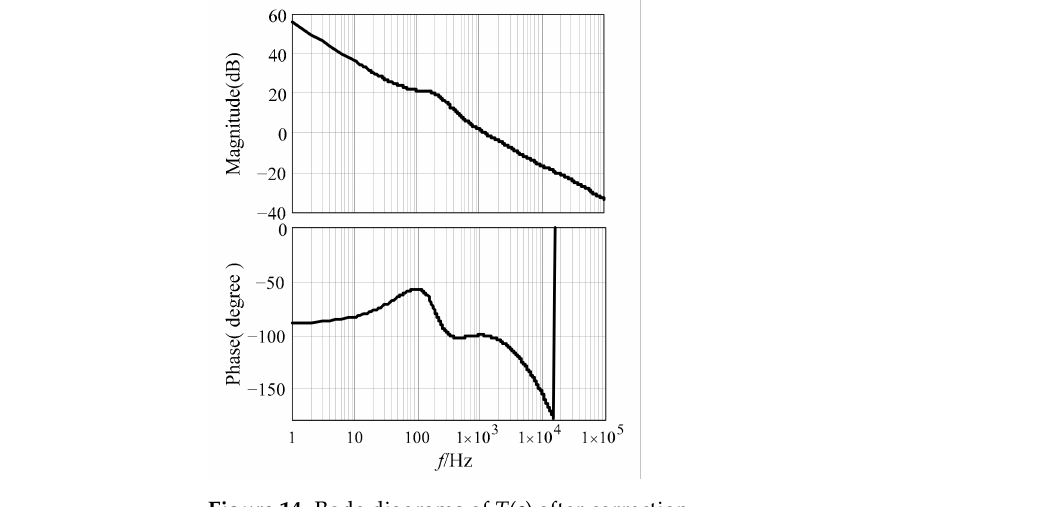
Figure 14. Bode diagrams of T ( s ) after correction.